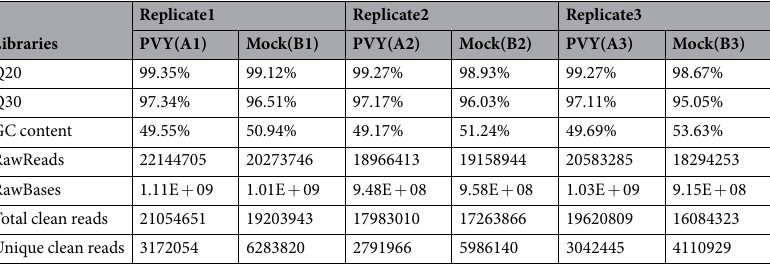
Table 1. The Small RNA sequencing results of PVY-infected and mock-inoculated